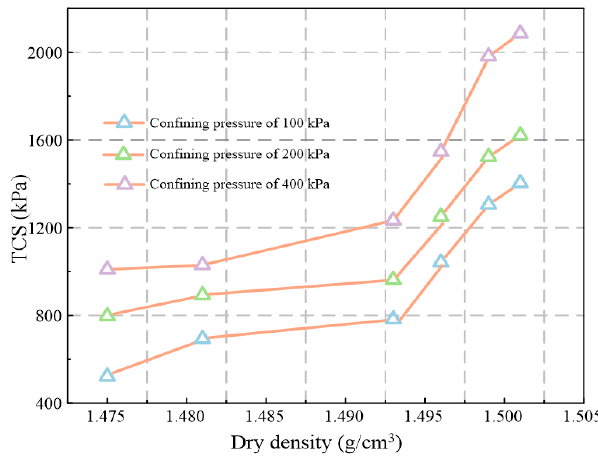
Figure 7. Relationship between TCS and dry density at three confining pressures.